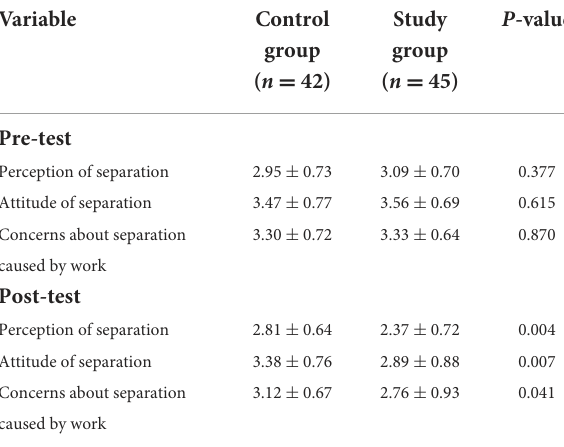
TABLE 3 Comparison of scores of SAS before and after the intervention between the two